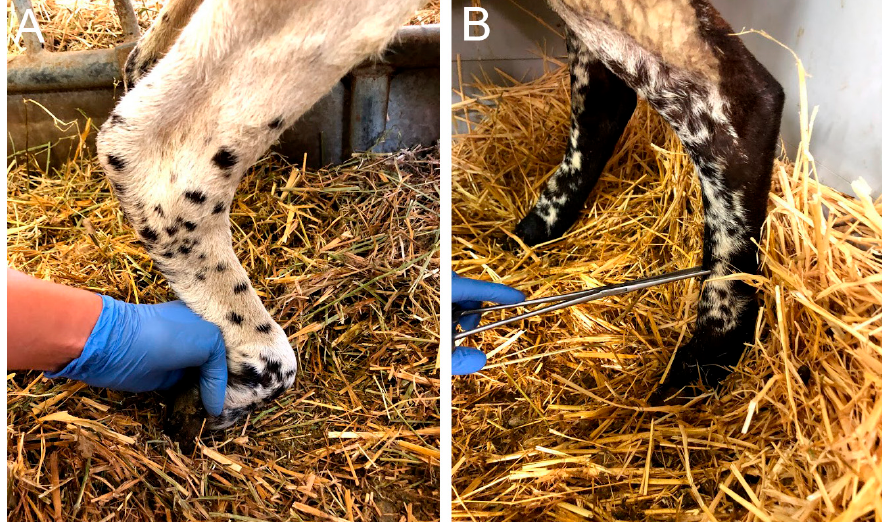
Figure 9. Photograph of the maneuver used for the proprioception test, assessing the capability of dorsiflexion of the hindfoot from a forced plantar flexion position ( A ). The flexor withdrawal reflex assesses the response to pinching the dorsum of the foot with a hemostat in a proximal point, a middle point ( B ) and a distal point.